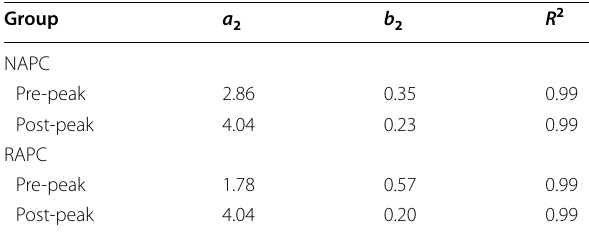
Table 8 Fitting values of parameter a